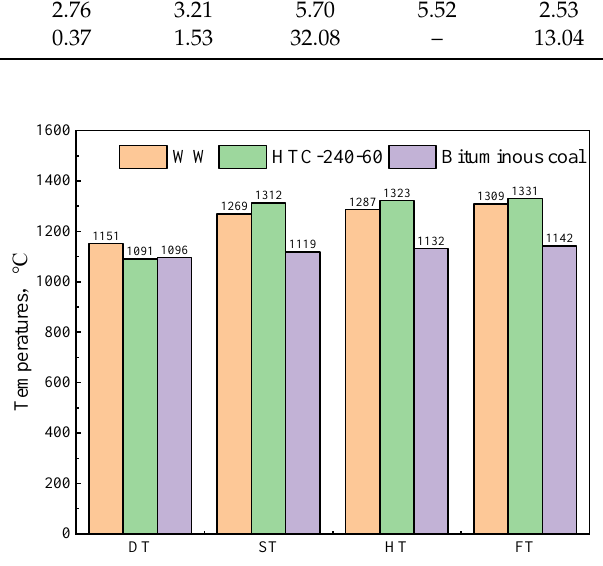
Figure 9. Ash melting point of WW and hydrochar